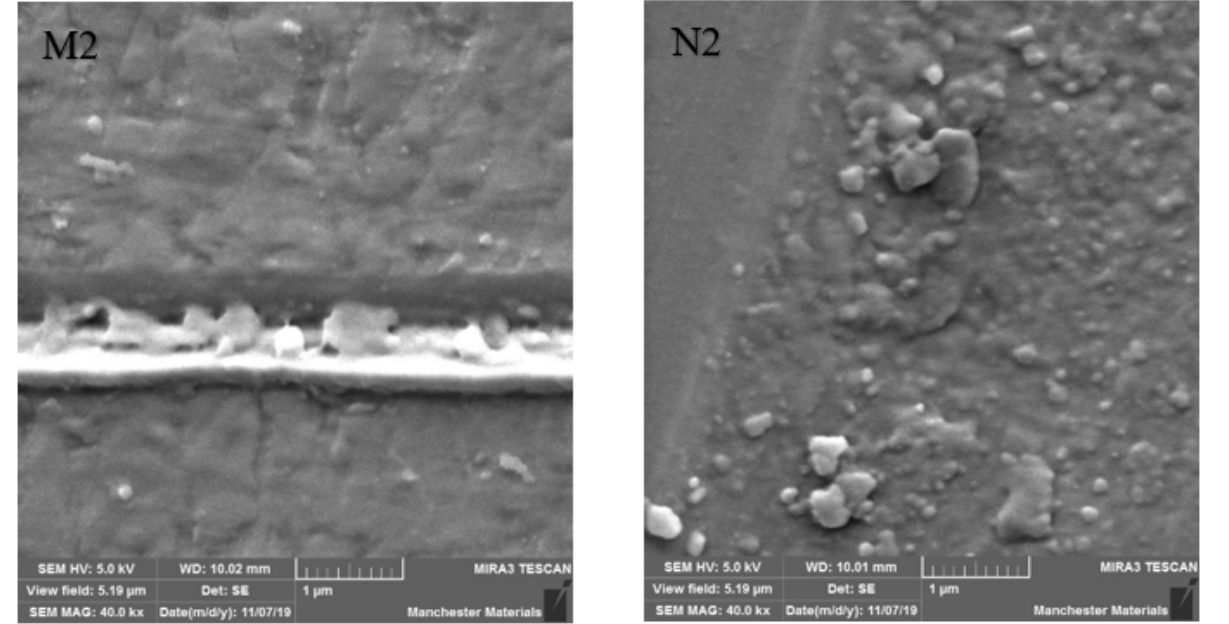
Figure 6. SEM imaging at 40 kx magnification at the point of impact. Note that the width of destruction and amount of particle debris are larger in N2 compared to M2.